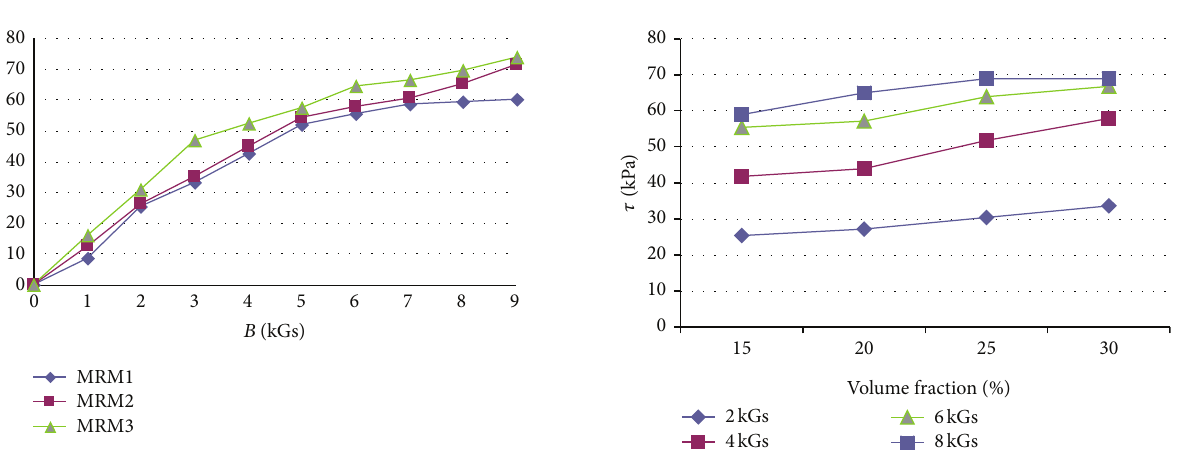
Figure 10: The shear stress of the different particle volume